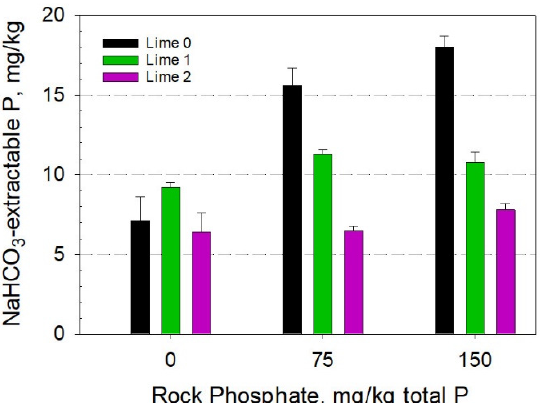
Figure 3. Soil P as affected by lime and rock phosphate. Error bars on top of larger bars are the standard deviation of the measured samples.